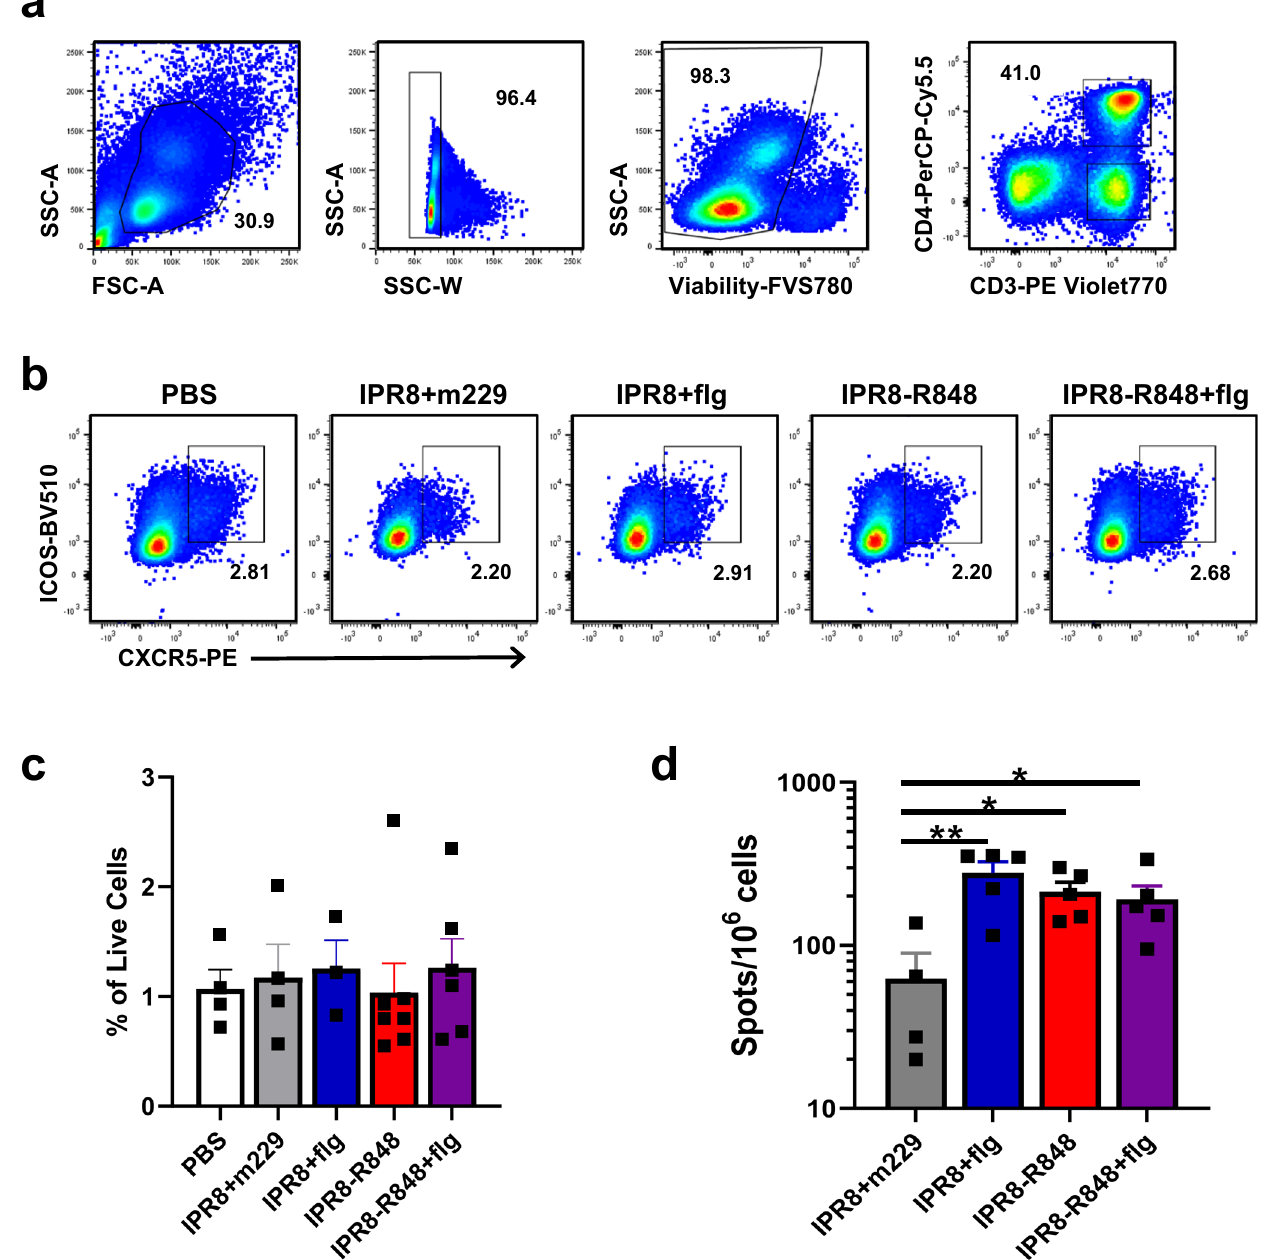
Fig. 4 Inclusion of adjuvant does not result in detectable increases in the total number of Tfh in circulation at d10 p.b., but alters the quantity of in fl uenza virus-speci fi c Tfh in the draining lymph node following challenge. PBMC collected from newborn NHP at d10 p.b were assessed for the presence of circulating T follicular helper cells by fl ow cytometry. Three age-matched untreated controls were included in the PBS group to increase sample size. a Gating strategy to identify live CD4 + T cells. Tfh were de fi ned as CXCR5 + ICOS + cells within this population as shown by representative data in b . c Average frequencies of Tfh as a percentage of live cells in circulation. d A separate group of vaccinated infants was challenged by infection with 1 × 10 10 EID50 of PR8 divided equally between the intranasal and intratracheal routes. On d14 p.c., tracheobronchial lymph nodes were isolated. IL-21 production was induced by culture in the presence of pooled peptides from the NA, HA, M1, and NP proteins (0.1 µg/ml for each peptide) for 48 h. IPR8 + m229 n = 4, adjuvanted vaccine groups n = 5. Statistical signi fi